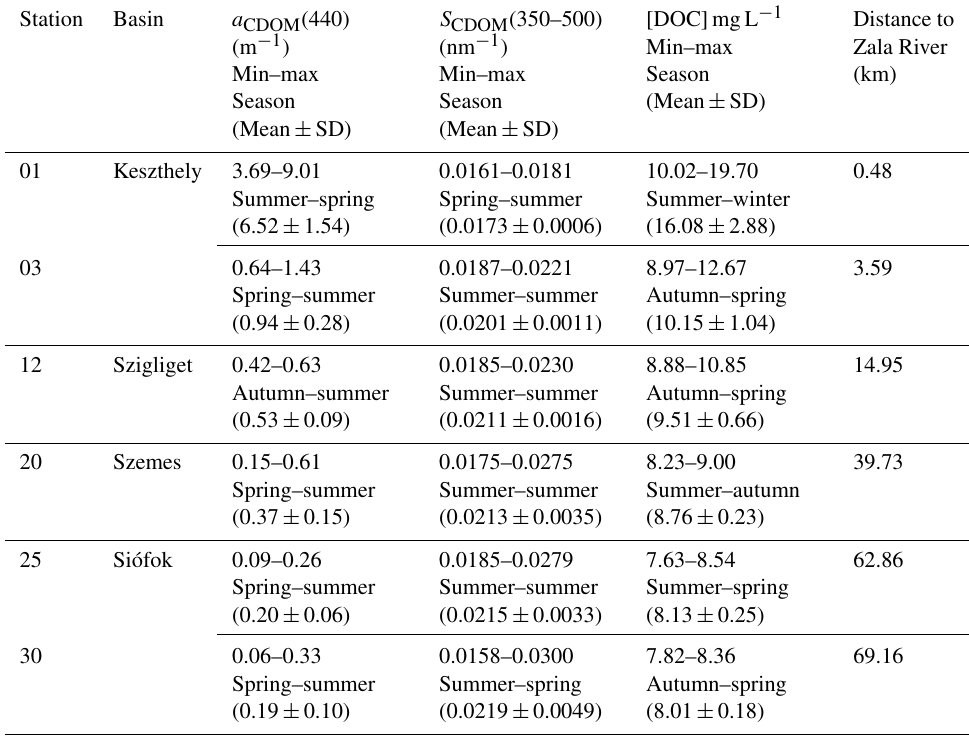
Table 2. Values of CDOM absorption coefficient at 440nm, CDOM slope coefficient between 350 and 500nm, DOC concentration, E 2 : E 3 ratio, SUVA254 and mean distance of the basin to Zala River. Values obtained for CDOM seasonal variation.